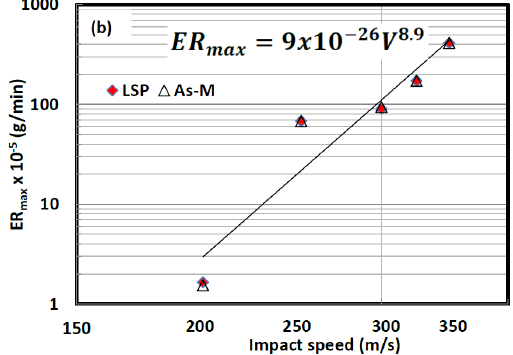
Figure 11. Effect of impact speed on ( a ) erosion initiation and ( b ) ER max .